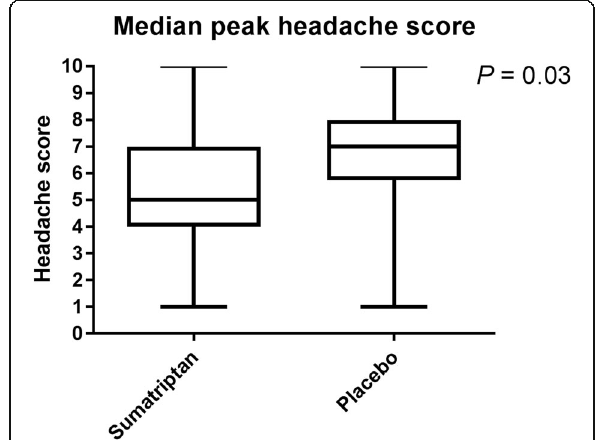
Fig. 4 Median peak headache score. Difference in median peak headache score between the two treatment days. Peak headache score was significantly higher on the placebo day compared to the sumatriptan day ( p = 0.03)